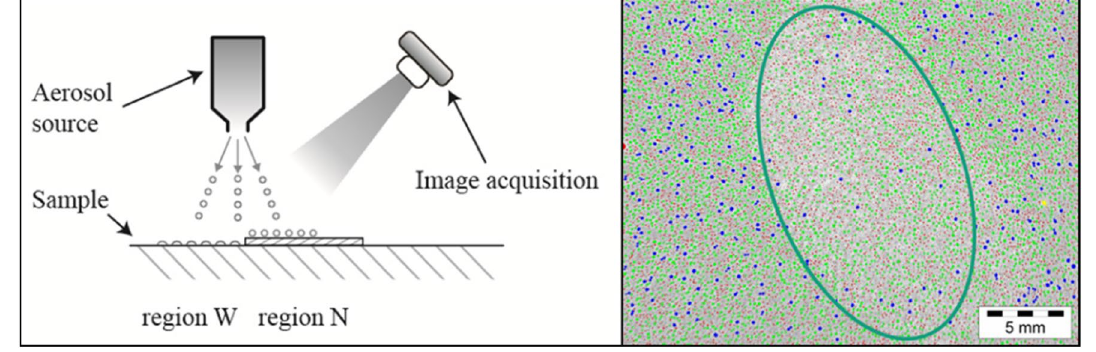
Fig. 2 Left: Using the Aerosol Wetting Test (AWT), the water drop- let size distribution is imaged, and in wettable surface regions (W) wider droplets are found than in regions (N) with less wettable sur-